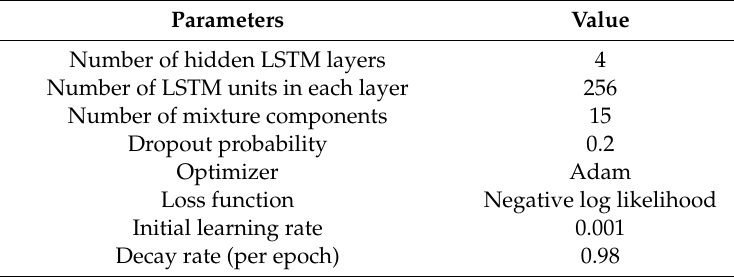
Table 1. The optimal parameter configuration of the BiRMDN model. BiRMDN: bidirectional recurrent mixture density